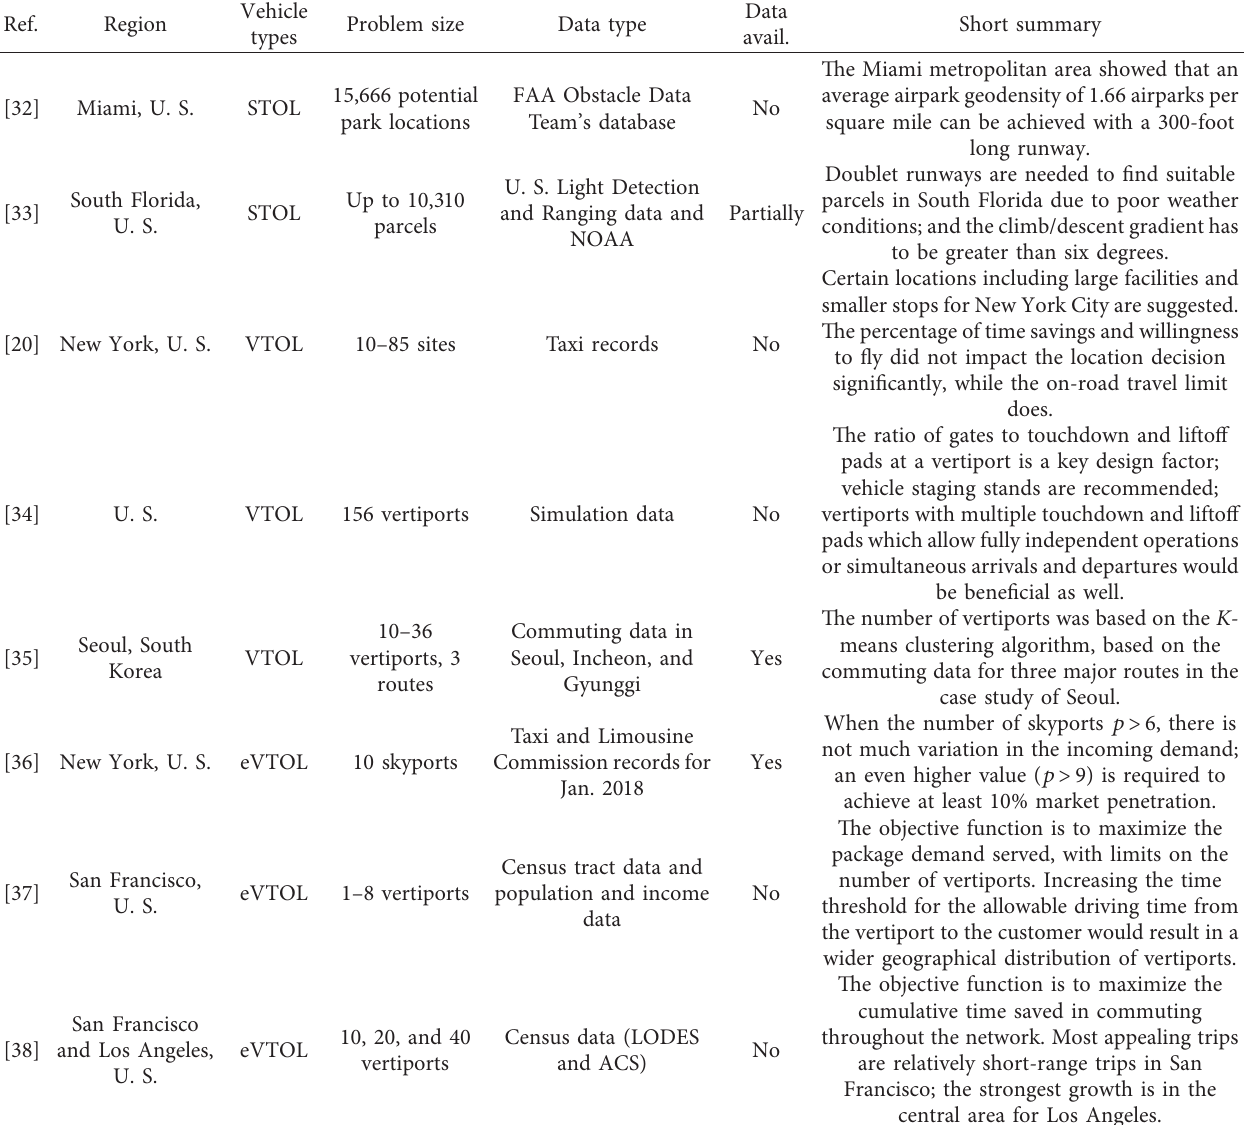
Table 2: An overview of the ODAM port design and location